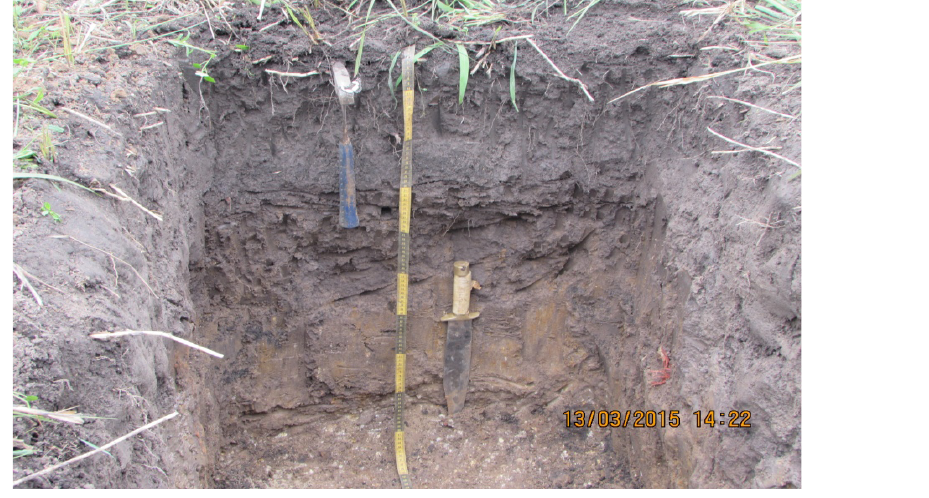
Figture 2. Soil profile in the lower slope of Yabayo